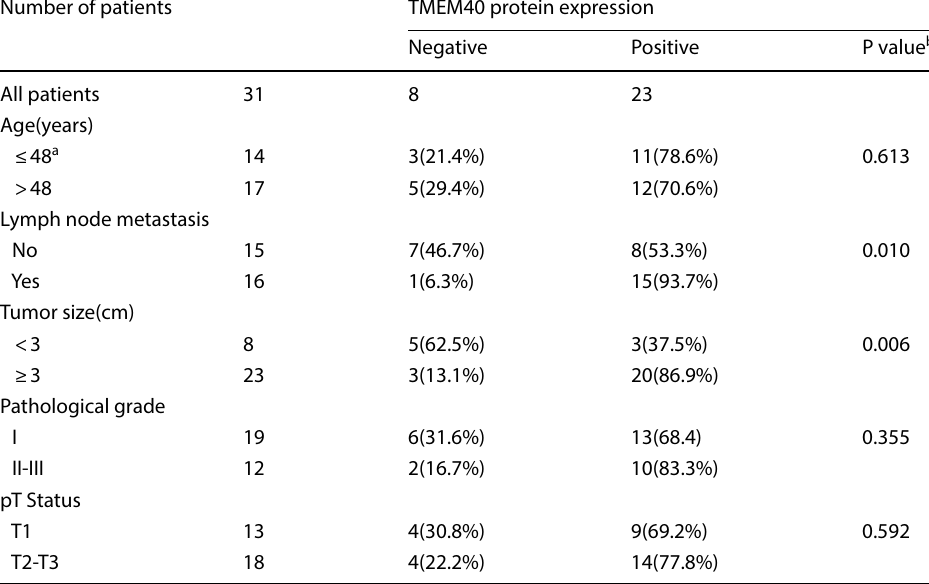
Table 2 Relationship of TMEM40 expression and clinicopathological features in cervical cancers